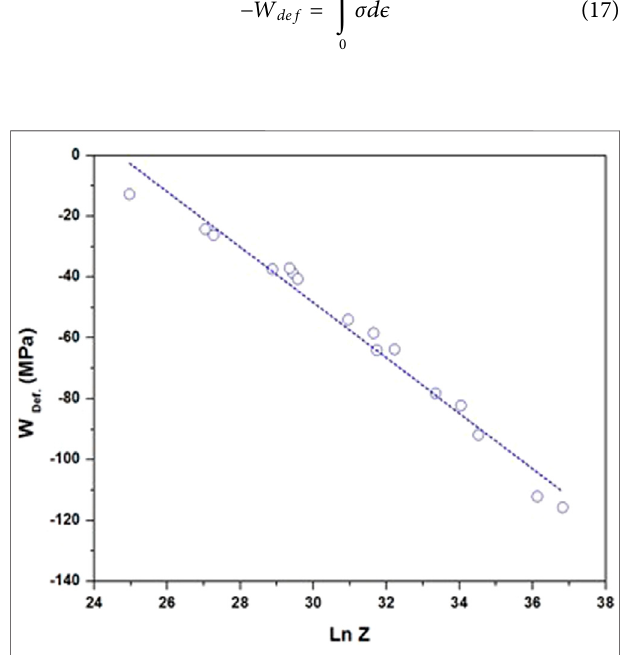
FIGURE 9 | Deformation energy versus the Zener – Hollomon